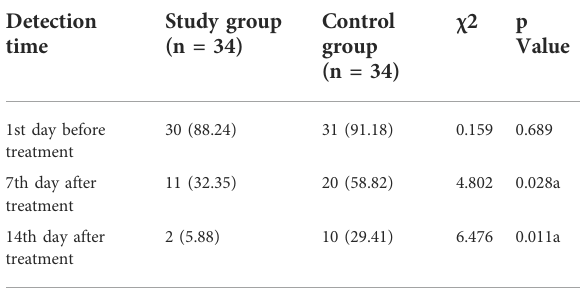
TABLE 5 Comparison of positive rate of bacterial culture on wound surface between two groups, n